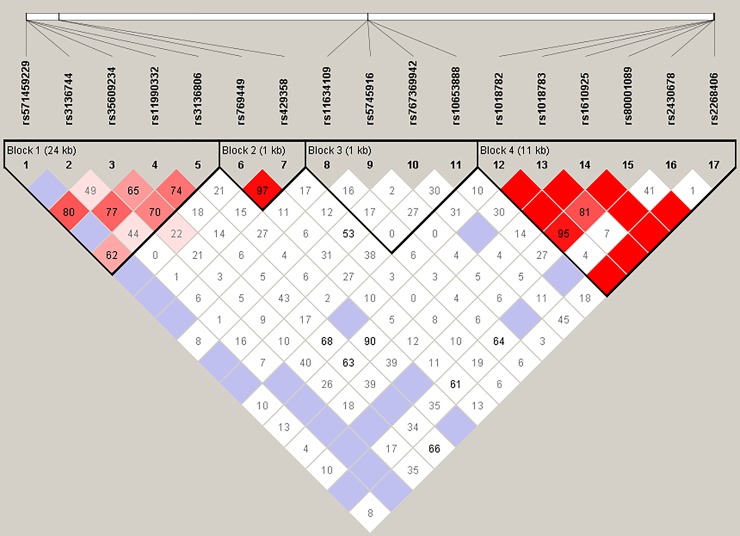
Linkage disequilibrium plot of all studied LOAD blood gene variants.D' (pairwise SNP correlation) values were represented in the boxes. The plot’s block 1, 2, 3 and 4 were defined according to the genes in the following order; POLβ, APOE, NEIL1 and UNG.